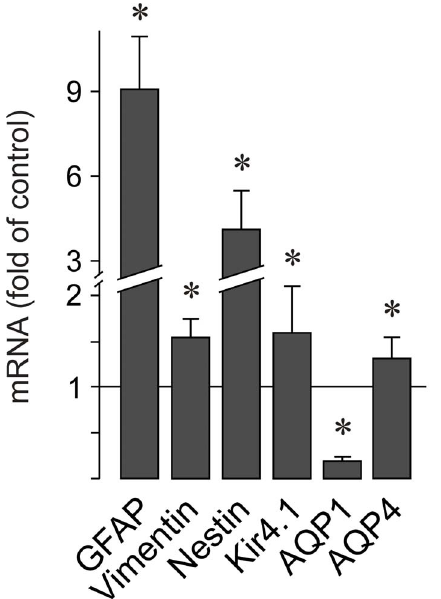
Figure 3. Age-dependent alterations in the immunolocalization of AQP1. Retinal slices were obtained from control (SD; above ) and transgenic (TG) rats ( middle and below ). Cell nuclei were labeled with Hoechst 33258 ( blue ). The images below display co-immunolabeling of retinal slices against AQP1 ( green ) and GFAP ( red ). Double labeling of both proteins yielded a yellow-orange merge signal. Arrows , AQP1- positive amacrine cells. Filled arrowheads , AQP1-positive Mu¨ller cell fibers. Unfilled arrowheads , GFAP- and AQP1-positive glial processes that surround large vessels. *, large vessel. GCL, ganglion cell layer; IPL, inner plexiform layer; INL, inner nuclear layer; NFL, nerve fiber layer; ONL, outer nuclear layer; OPL, outer plexiform layer. Bars, 20 m m.